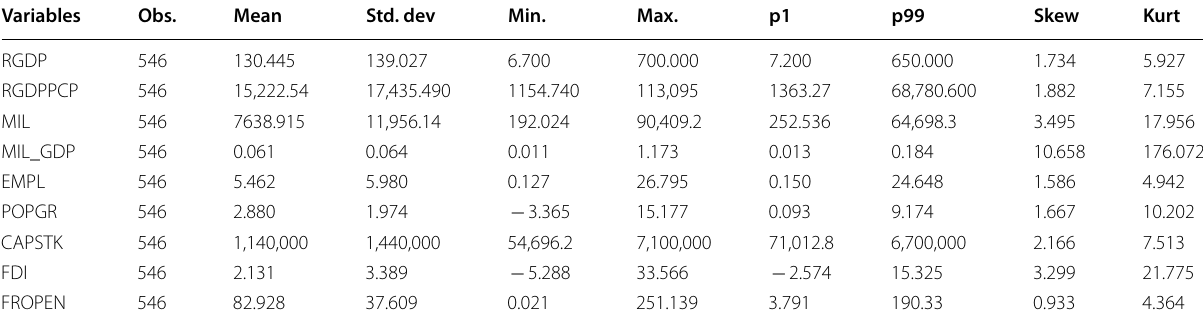
Table 2 Descriptive statistics